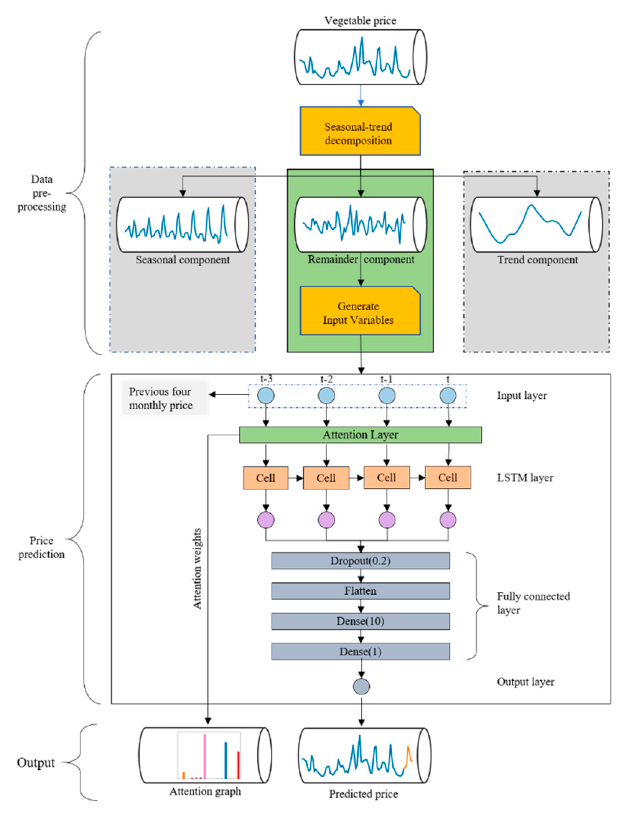
Figure 2. Structure of proposed model.